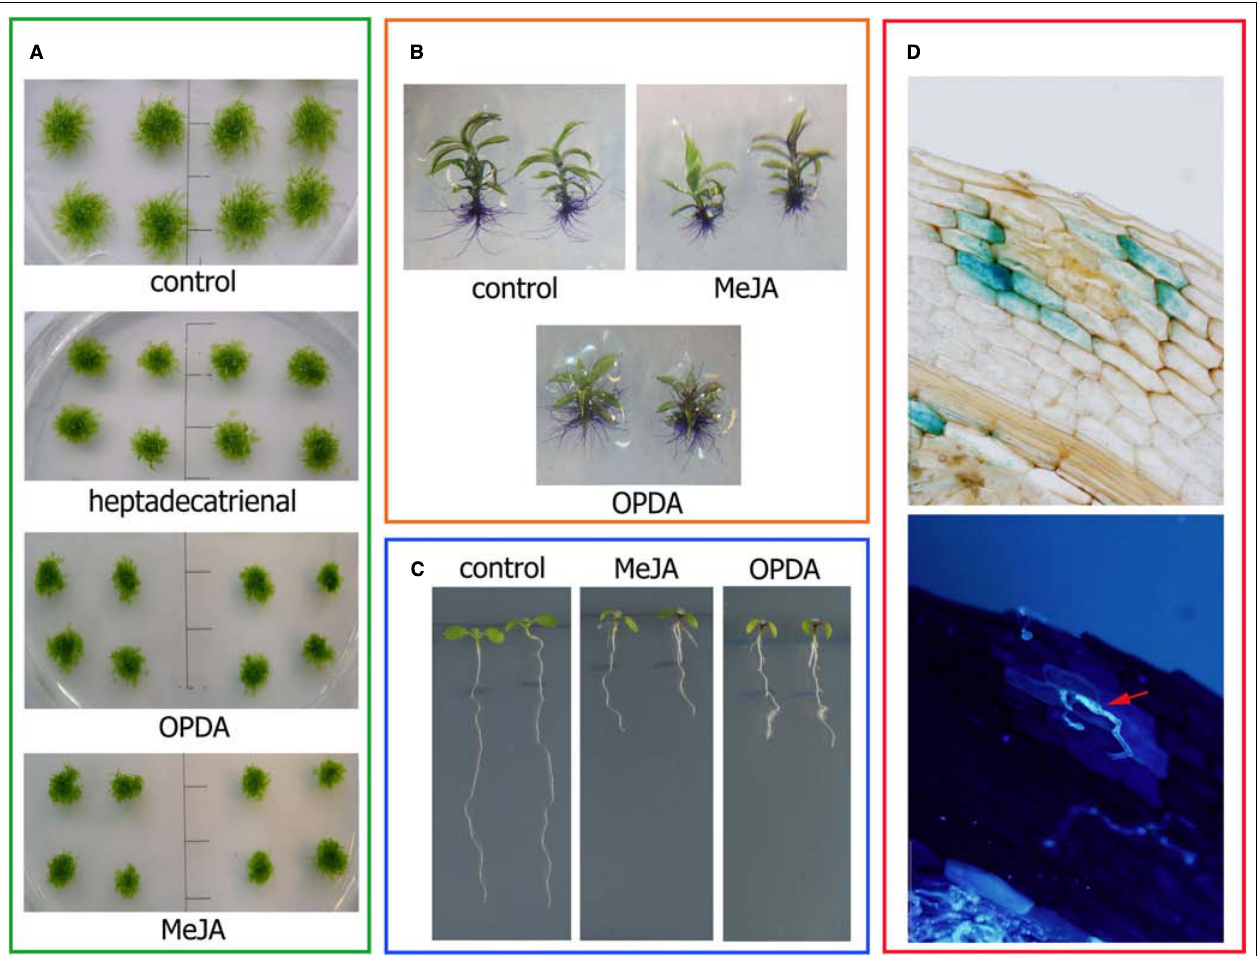
FIGURE 3 | Plant oxylipins participate in development and defense. (A) Moss colonies showing inhibited growth compared to control plants when tissues are incubated with 50 µ M Pp α -DOX-derived heptadecatrienal, 50 µ M PpLOX-derived OPDA or 50 µ M methyl jasmonate (MeJA). The scale bars represent 1 cm. (B) Moss gametophores showing reduced growth of rhizoids compared to control gametophores when tissues are incubated with 50 µ M OPDA or 50 µ M methyl jasmonate (MeJA). Rhizoids were stained